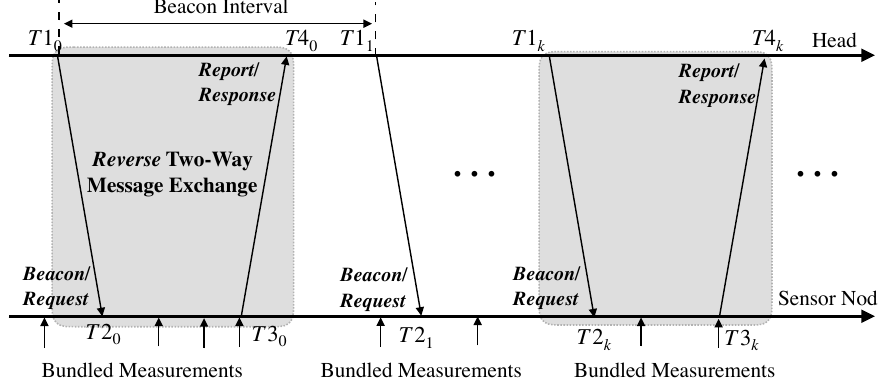
Figure 1. The reverse two-way message exchange and data bundling illustrated in EE-ASCFR [1].